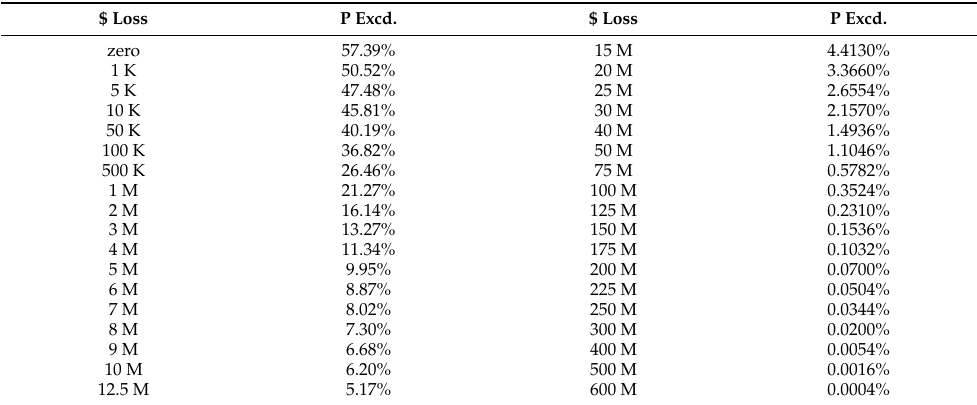
Table 9. Probability that the loss to the model portfolio (P Excd.) exceed the stated values for the Lee et al. 2021 Model Portfolio. The loss simulations were reported to the dollar. No deductibles were considered in the loss calculations.